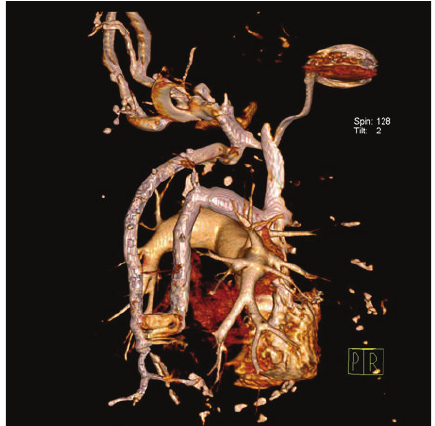
Figure 2: Volume rendering CT image shows the anomaly from the